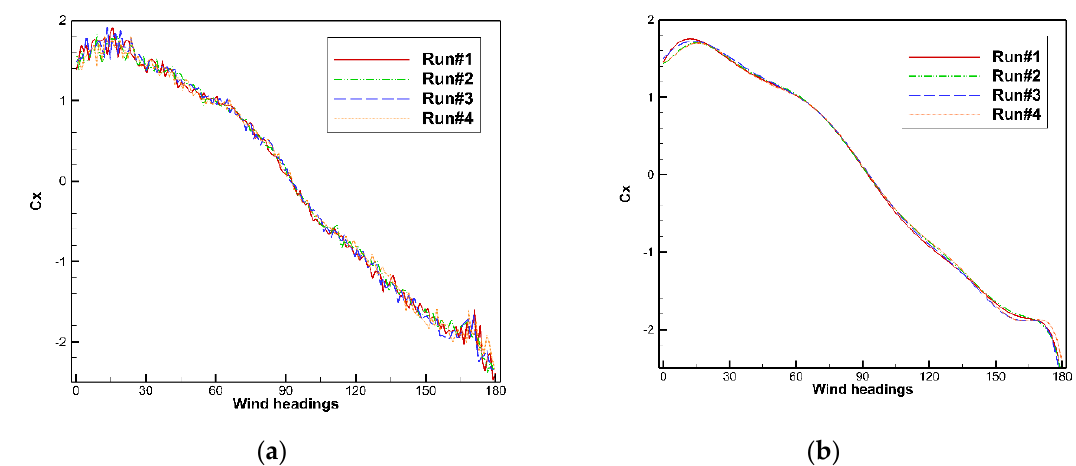
Figure 2. Vessel models for wind tunnel tests. ( a ) FPSO; ( b ) shuttle tanker; ( c ) membrane-type LNGC; and ( d ) moss-type LNGC.